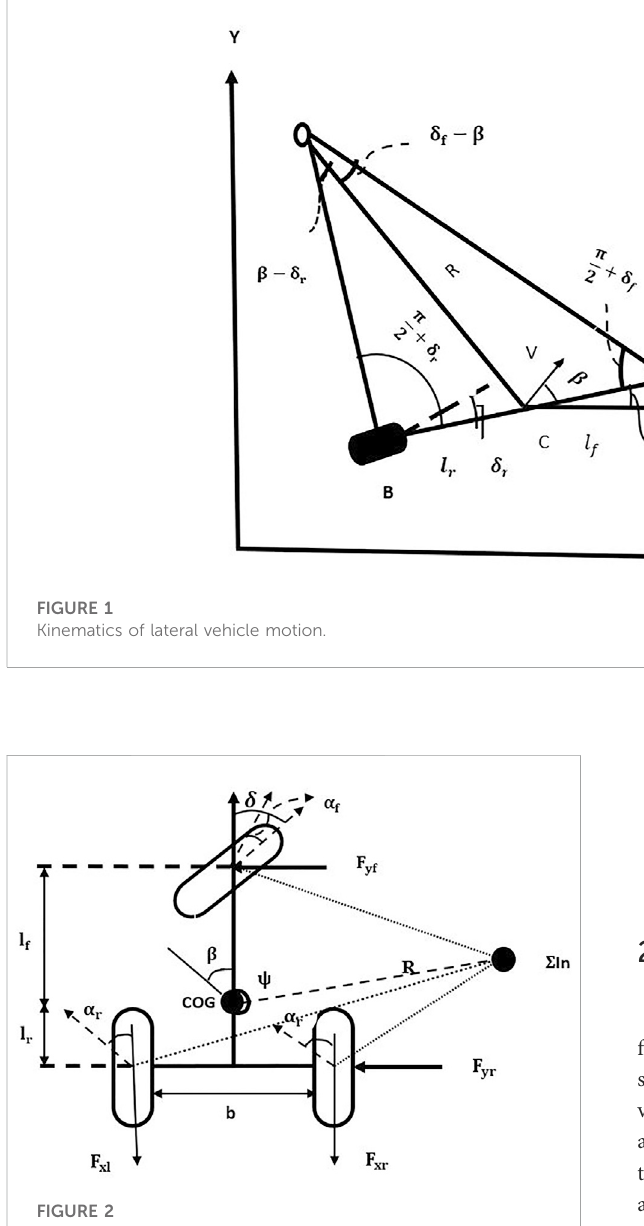
FIGURE 2 Tricycle model